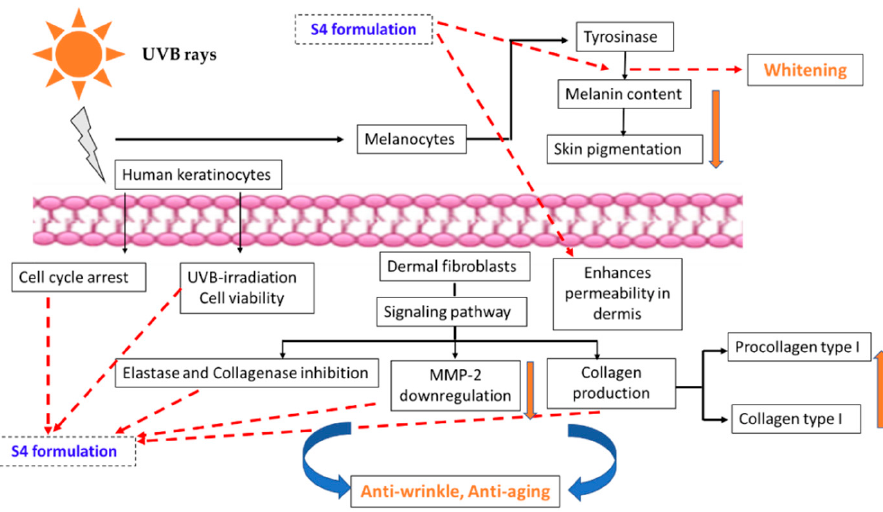
Figure 13. Summary of the main pathways of the UVB-induced effects on human keratinocytes, dermal fibroblasts, and melanocytes, and the potential mechanisms of the S4 hydrogel whitening and anti-aging effects.